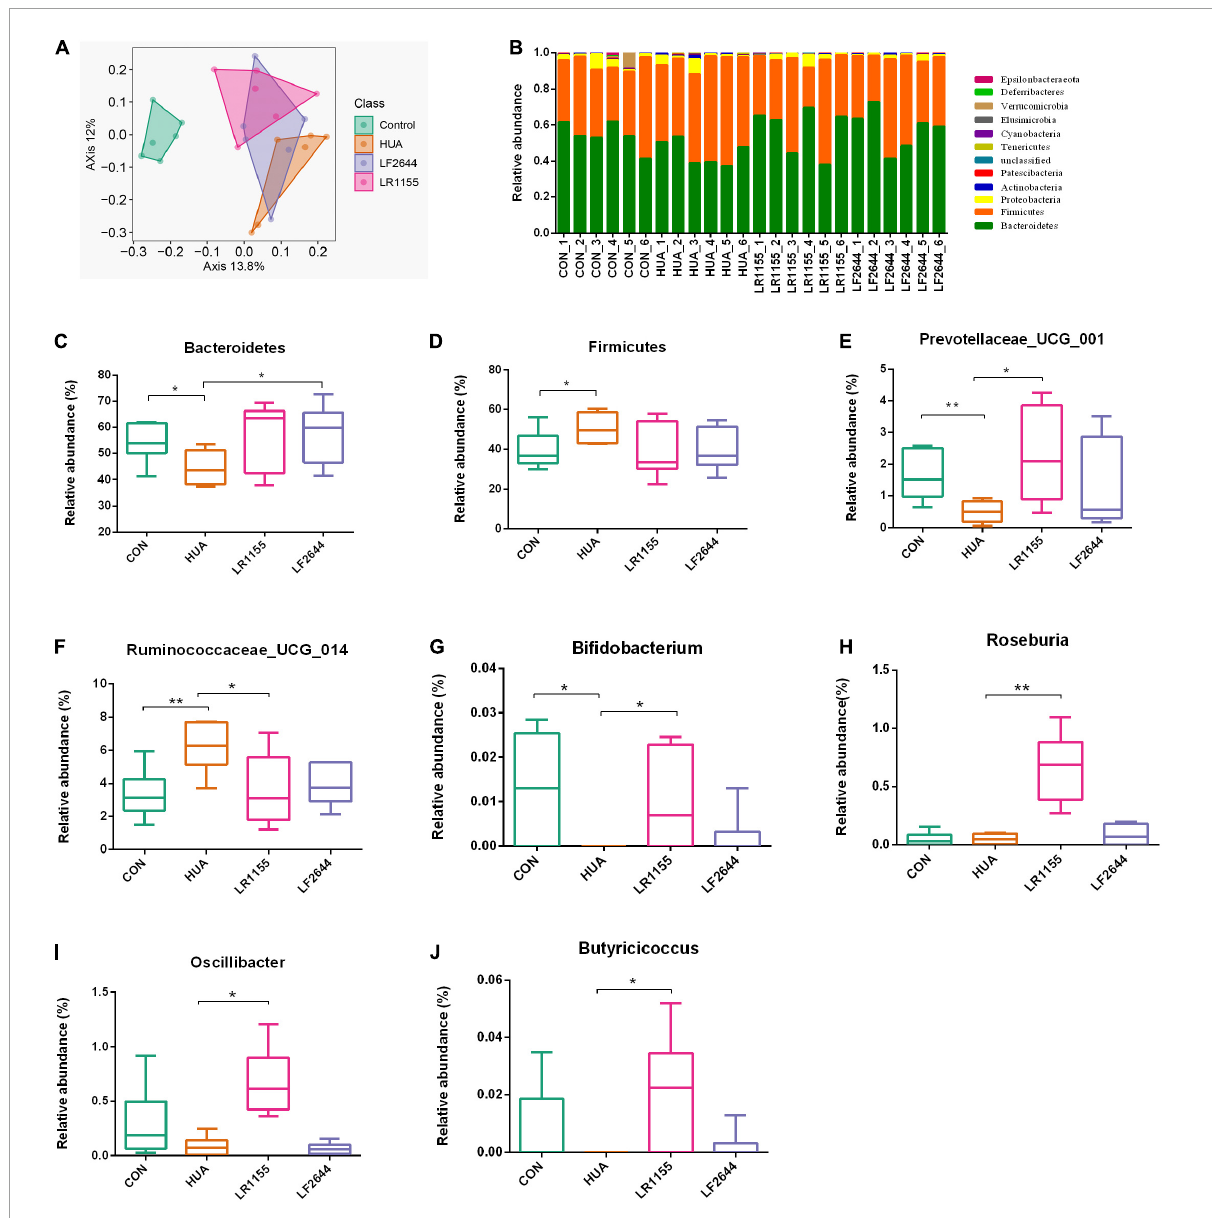
FIGURE5 Effects of LR1155 and LF2644 on the intestinal microbial composition of hyperuricemia rat. (A) Principle-coordinates analysis (PCoA) based on the Bray-Curtis distances among different samples. (B) Microbial community structure indicated by the percentile difference of bacteria at the phylum level. (C,D) The changes of gut microbial taxa at the phylum level ( Bacteroidetes and Firmicutes ). (E–J) The relative abundance of key differential genera. CON, control; HUA, hyperuricemia (model); n = 6; data are expressed as median with range (min to max). * P < 0.05, ** P < 0.01 vs. the model